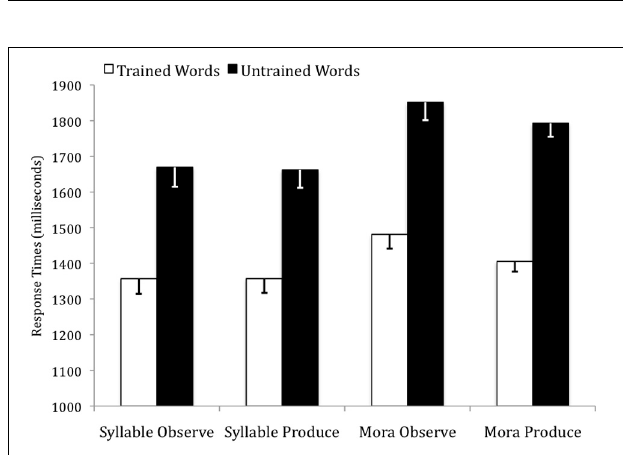
FIGURE 3 | Accuracy rates for trained and untrained words across the four instruction conditions in the auditory identification test.